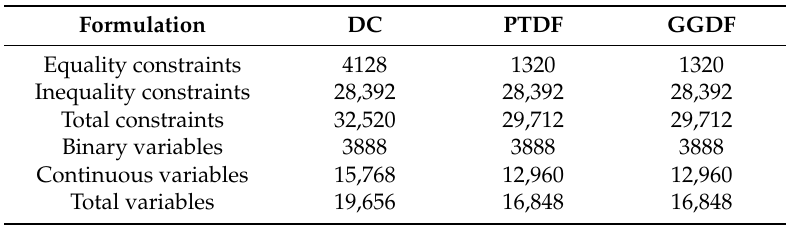
Table 4. Computational aspects for the IEEE 118-bus system.